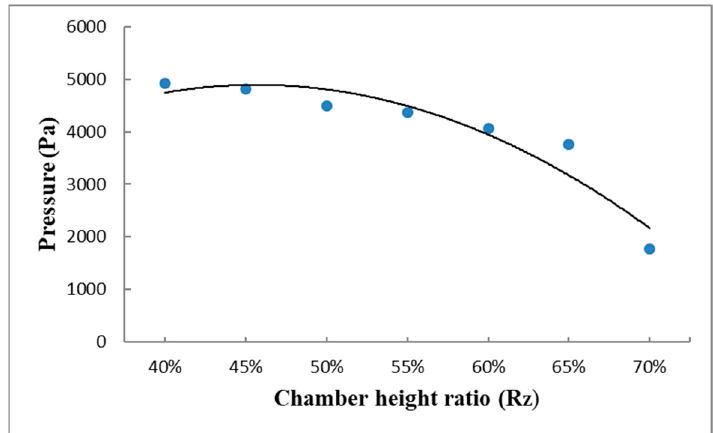
Figure 19. Air-pressure corresponding to height ratio R Z of OWC chamber.